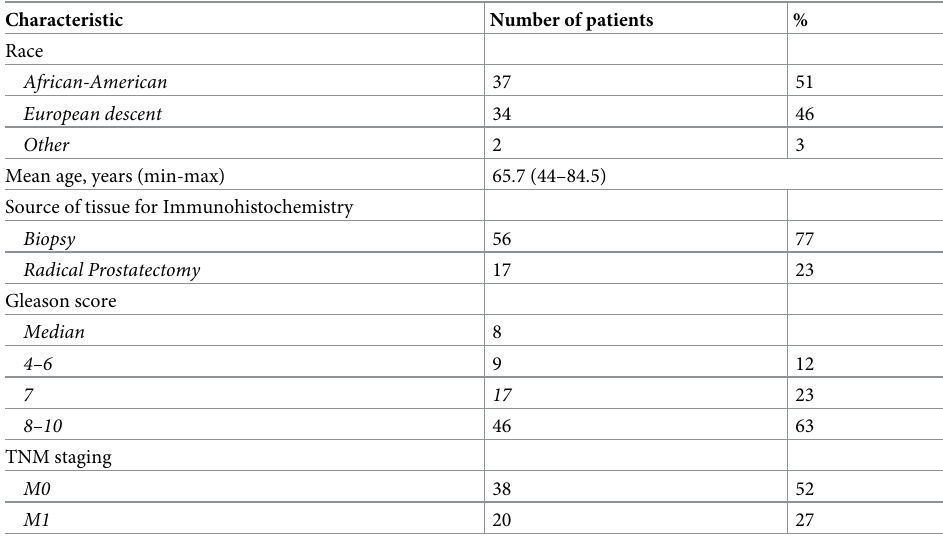
Table 1. Patient demographics and clinical characteristics at the time of diagnosis.